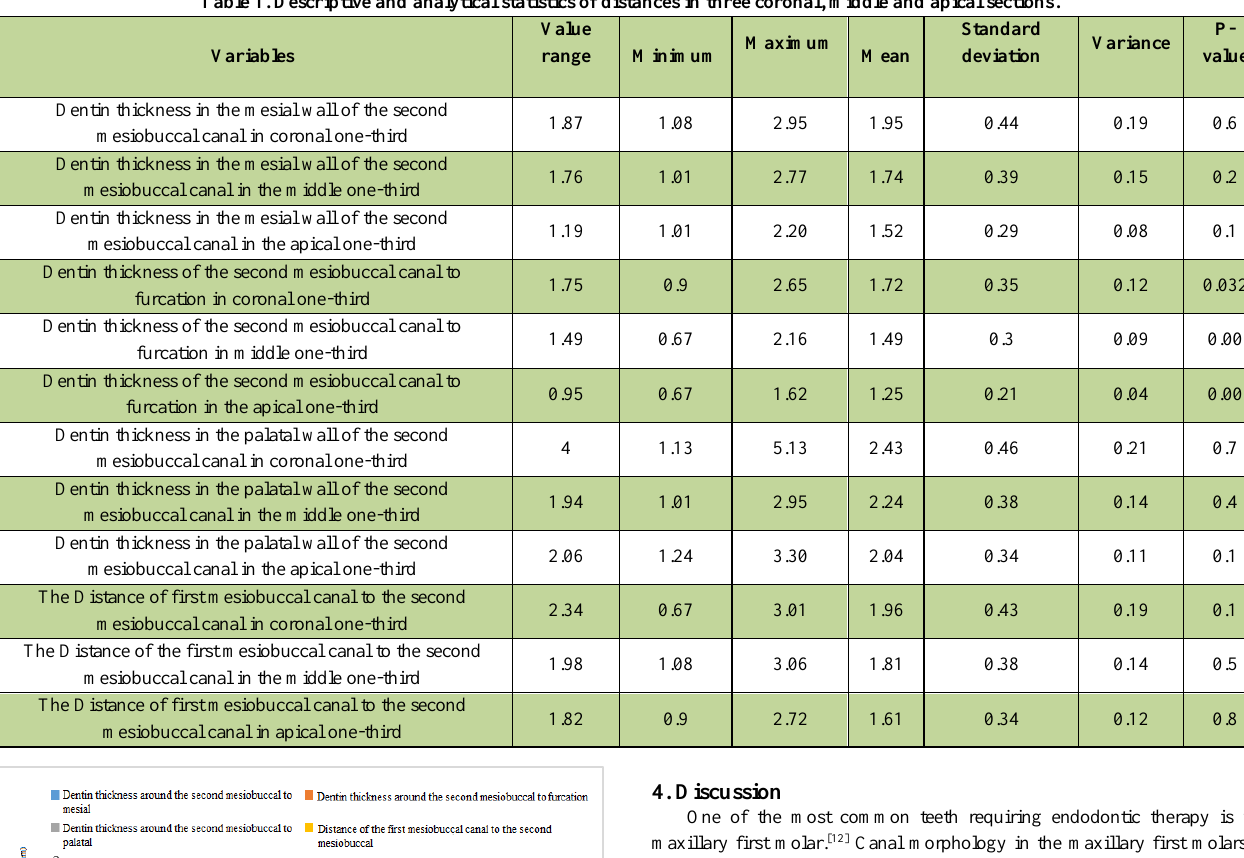
Table 1. Descriptive and analytical statistics of distances in three coronal, middle and apical